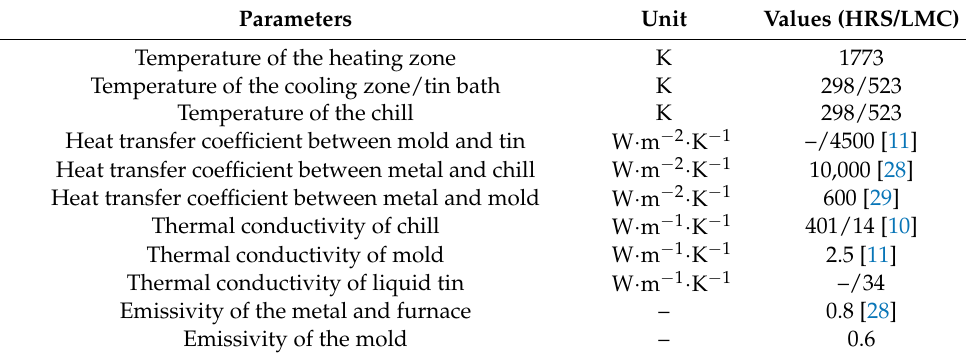
Table 2. The initial and boundary conditions during directional